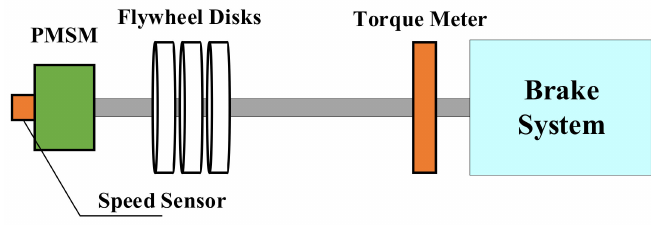
Figure 18. Load simulation system.